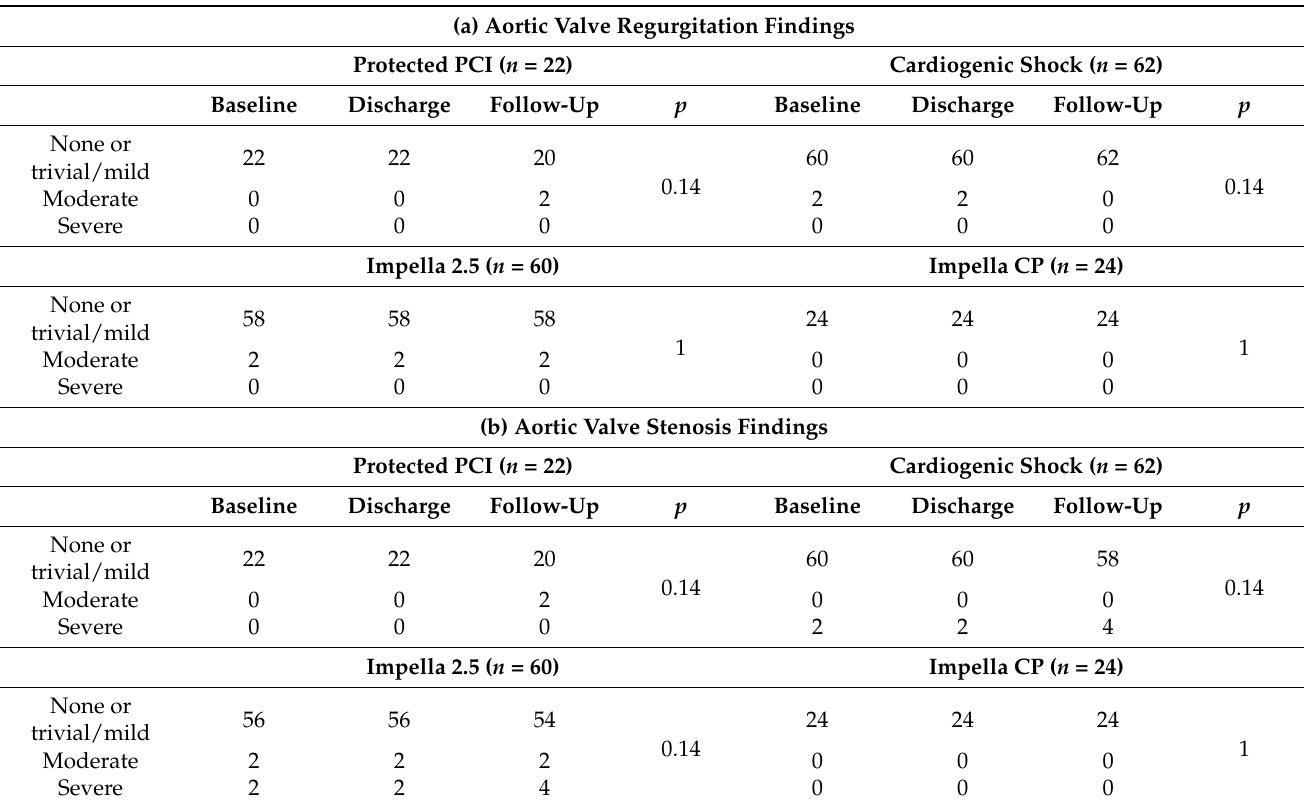
Table 3. Aortic valve